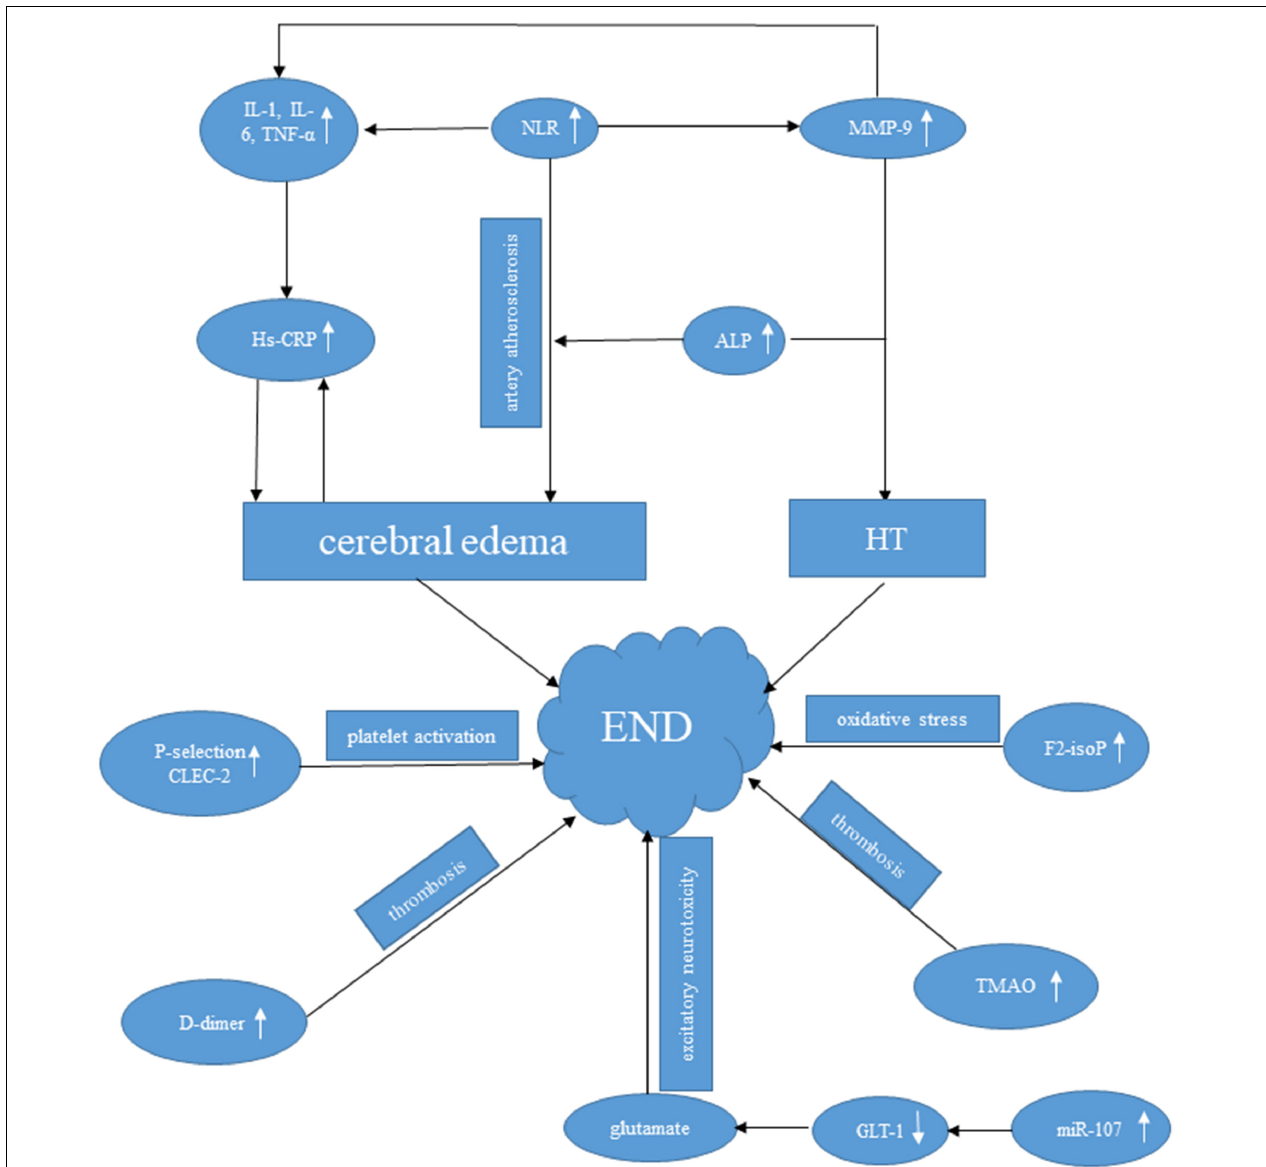
FIGURE 2 | Possible mechanisms of several valuable biomarkers to END following